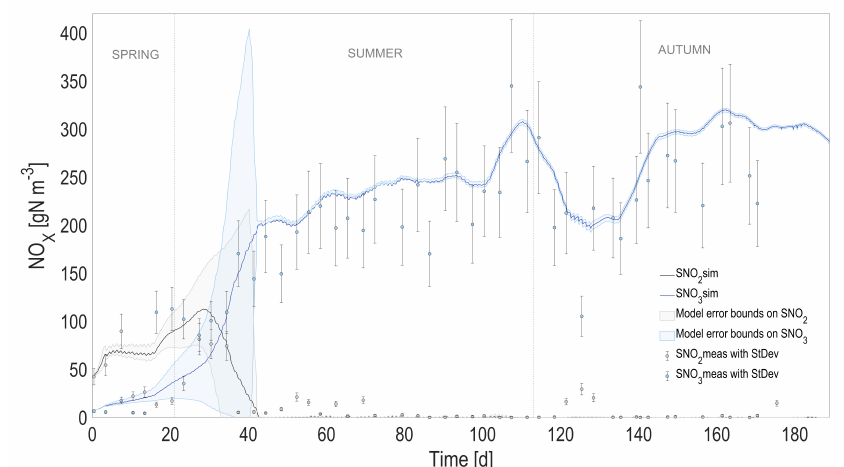
Figure 5. Full prediction capability of the coupled heat transfer and ALBA models. Comparison between full predictions (with simulated temperature) and measurements, for nitrite ( S NO nitrate ( S NO ). Shaded areas on model predictions represent the related 95% confidence 3